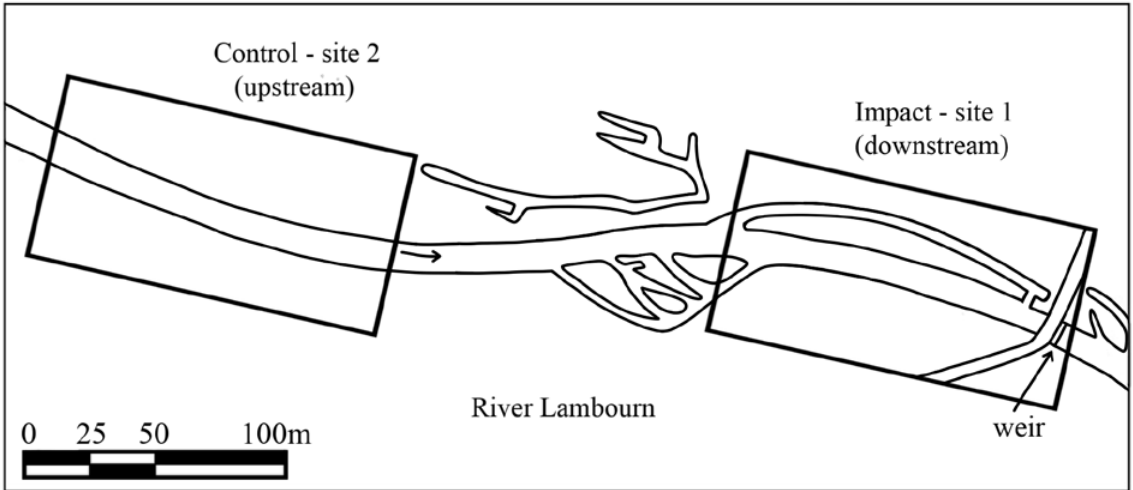
Figure 2. Location of Control (site 2) and Impact (site 1) sites on the River Lambourn. Arrow represents direction of water flow.